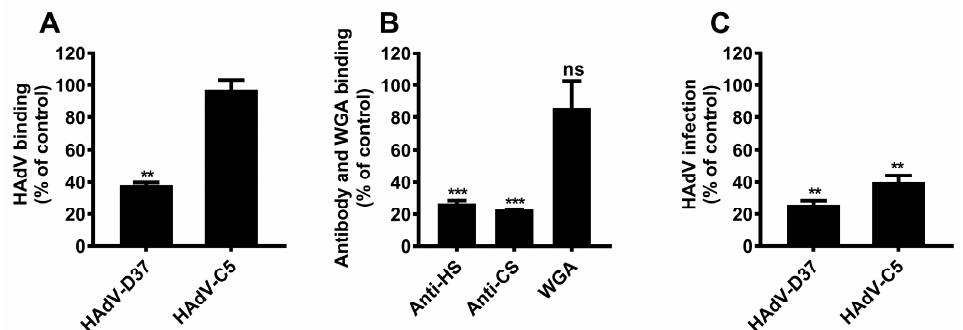
Figure 6. Sulfate groups on cell surface GAGs play multiple roles during HAdV binding to and infection of HCE cells. ( A ) Binding of 35 S-labeled HAdV-C5 and HAdV-D37 to cells grown with 25 mM sodium chlorate for 48 h prior to the binding experiment. Binding of virus is presented as percentage binding of untreated cells. ( B ) Cell surface expression of HS, CS, and total SA on cells grown with 25 mM sodium chlorate. Binding of antibodies and WGA to cells is presented as percentage binding of untreated cells. ( C ) HAdV-C5 and HAdV-D37 infection of cells grown with 25 mM sodium chlorate for 48 h prior to the infection experiment. Virus infection of cells is presented as percentage infection of untreated cells. Cells grown without sodium chlorate were used as controls. Error bars represent mean ± SEM. ns = not significant. ** P < 0.01 and *** P < 0.001 relative to control.